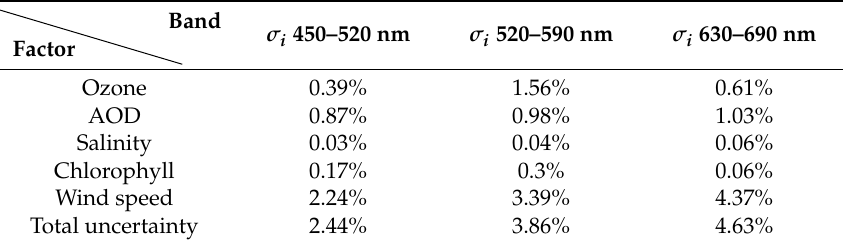
Table 9. σ i (Calibration coefficient uncertainties for Samples 5, 7, 10, and 11) from atmosphere and marine parameters (total uncertainty is the square root of the sum of the squares of the uncertainties from all five